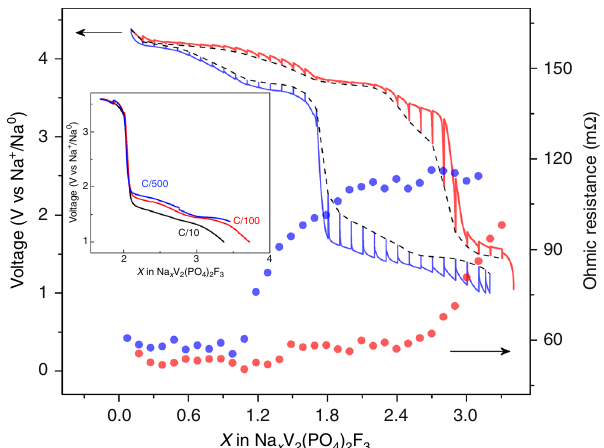
Fig. 3 Galvanostatic intermittent titration-technique (GITT) test of NVPF- 2.75 sample after the fi rst formation cycle. The cell was cycled at C/10 rate and the relaxation time was controlled either by 4 h or by limiting d V /d t < 0.1 mV/s; The red and blue solid lines show the experimental GITT curve on charge and discharge respectively, with the black dashed line showing the equilibrium potential after each relaxation process. The red and blue fi lled circles represent the Ohmic resistance at each point on charge and discharge process respectively. The inset shows NVPF-2.75/Na cell cycled at C/10, C/100, and C/500 within the range of voltage drop during the fi